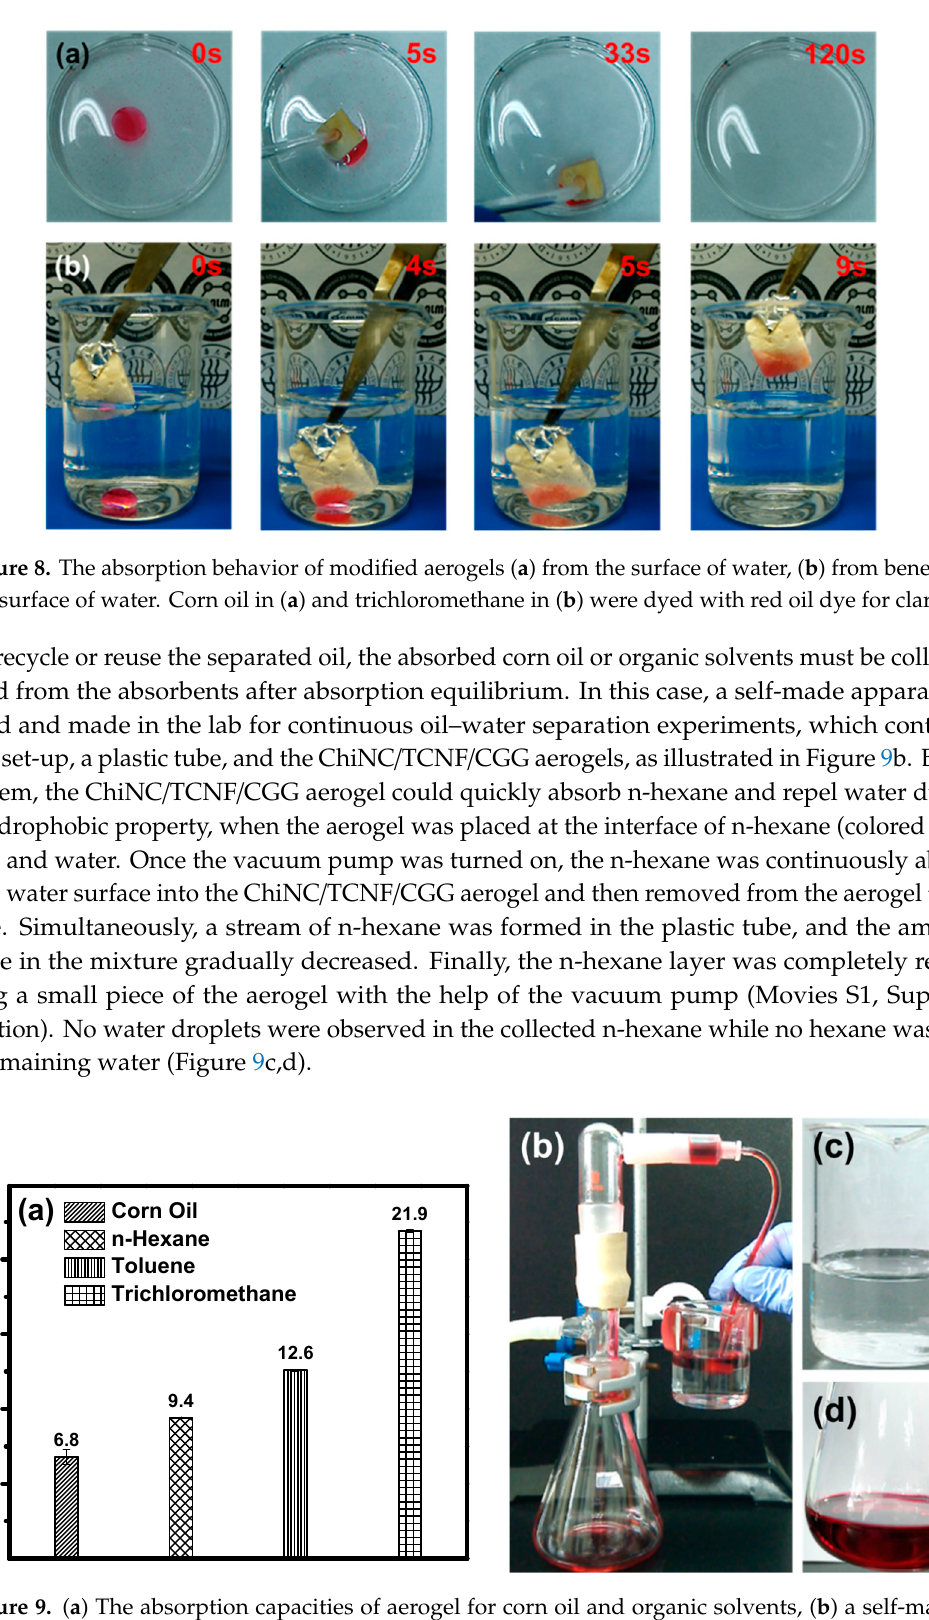
Figure 9. ( a ) The absorption capacities of aerogel for corn oil and organic solvents, ( b ) a self-made apparatus for continuous oil absorption, ( c ) water remained after the separation, and ( d ) the collected n-hexane (n-hexane was colored with red oil dye for clarity).